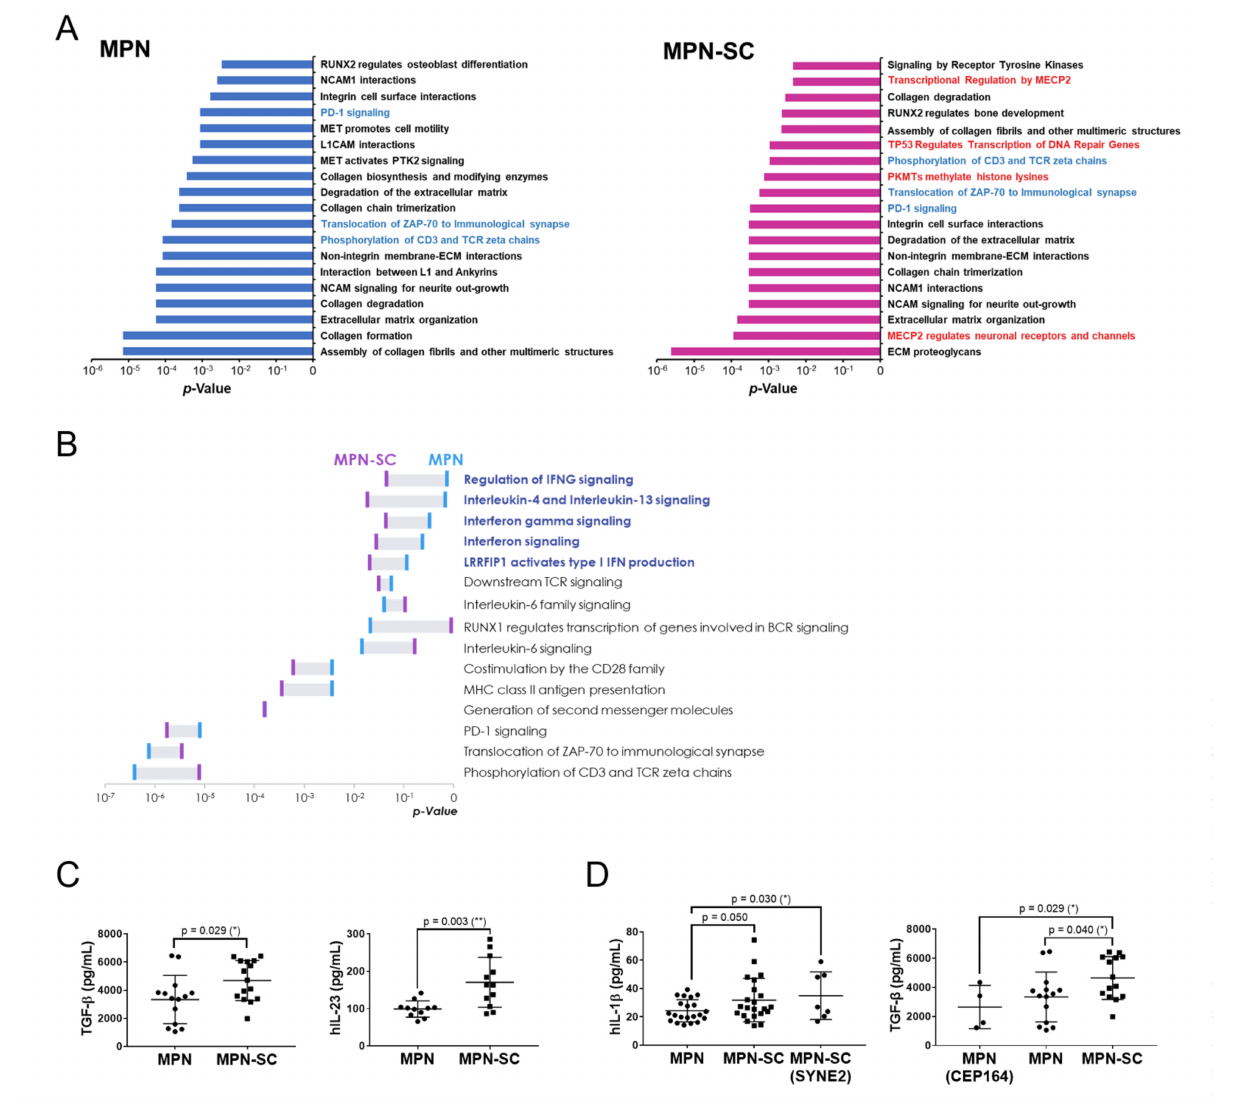
Figure 5. Gene ontology functional analysis and cytokine measurement in both groups of MPN pa- tients. ( A ) Gene ontology functional analysis of genes with variants in the control group (left) and the SC group (right). Immune-related pathways are highlighted in light-blue color. Pathways pertinent to epigenetic regulation and genomic stability are highlighted in red. ( B ) Differentially involved pathways linked to the mutated genes in both groups. Some key inflammation pathways enriched in SC samples are highlighted in blue. The Reactome was applied for this analysis. ( C ) Comparison of TGF- β and IL-23 levels in the two groups of MPN patients. ( D ) Comparison of IL-1 β and TGF- β levels in the indicated groups of MPN patients. *: p < 0.05; **: p < 0.01 by Student’s t